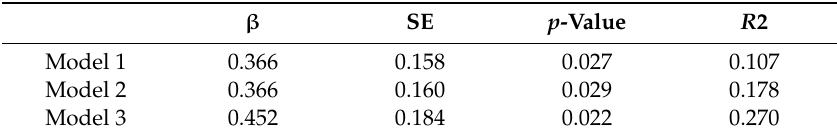
Table 4. Multivariate analysis: the association between daily intake of α -tocopherol and the BMD